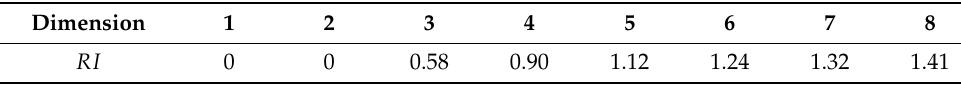
Table 2. The random consistency index of the judgment matrix.